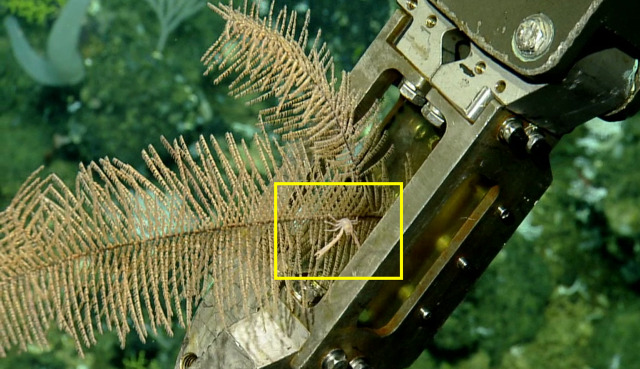

Uroptychus
bellus